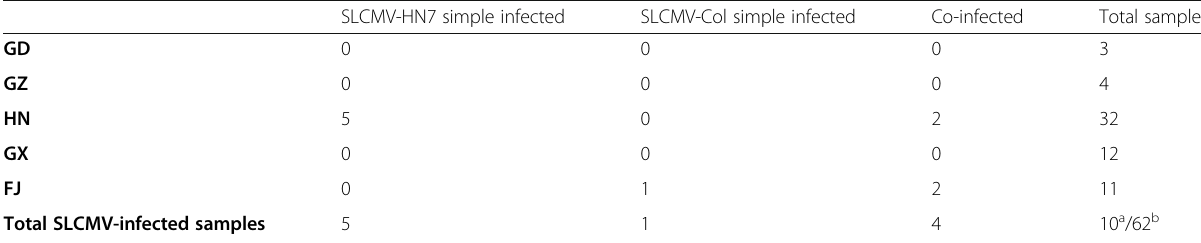
Total SLCMV-infected samples